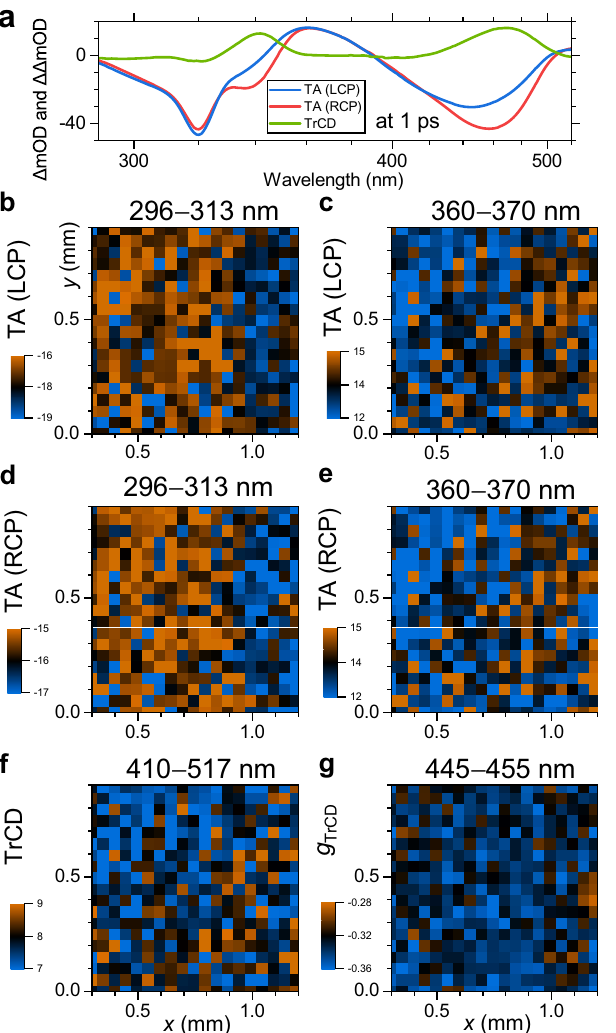
Fig. 6 Ultrafast transient absorption and circular dichroism mapping of a c-PFBT thin fi lm at 1 ps. a Transient absorption spectra for probing with left-circularly polarised light (blue) and right-circularly polarised light (red), as well as the resulting TrCD spectrum (green), averaged over the complete map. b Transient absorption map for probing with left-circularly polarised light averaged over the wavelength range 296 − 313 nm. c Transient absorption map for probing with left-circularly polarised light (average: 360 − 370 nm). d Transient absorption map for probing with right-circularly polarised light (average: 296 − 313 nm). e Transient absorption map for probing with right-circularly polarised light (average: 360 − 370 nm). f Transient circular dichroism map (average: 410 − 517 nm). g Map for the dissymmetry factor g TrCD (average: 445 − 455 nm). circular dichroism, with coupling between local electric and magnetic transition dipole moments, which would predict thickness-independent gabs, g lum 19 and also g TrCD as well as pronounced CD activity in the electronically excited state. The TrCD signal for a given fi lm thickness is still linearly dependent on the pump fl uence, i.e. it scales with the number of initially excited polymer units (cf. Fig. 4b, c). The supramolecular nature of the transient chiral response manifests itself in terms of an additional constant scaling factor which increases the TrCD signal, which means it becomes much bigger for thicker fi lms.